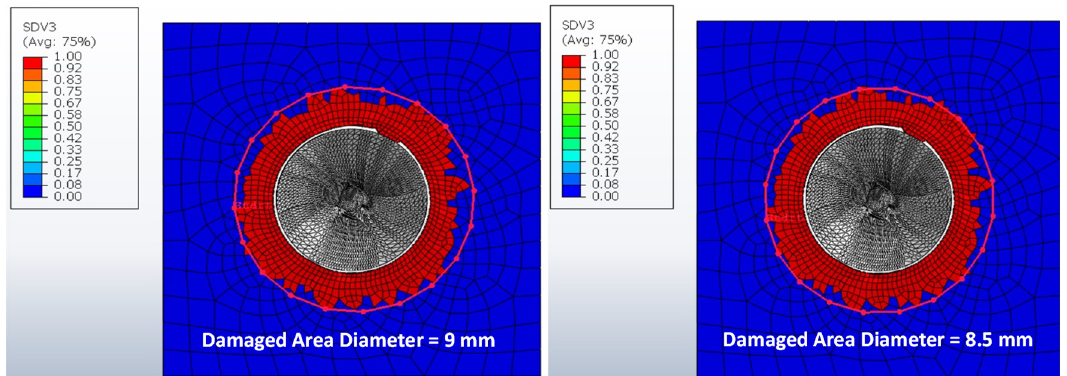
Figure 6. Illustration of drilling-induced damage by fuzzing and spalling: ( Right ) 3000 rpm and ( Left ) 5000 rpm.